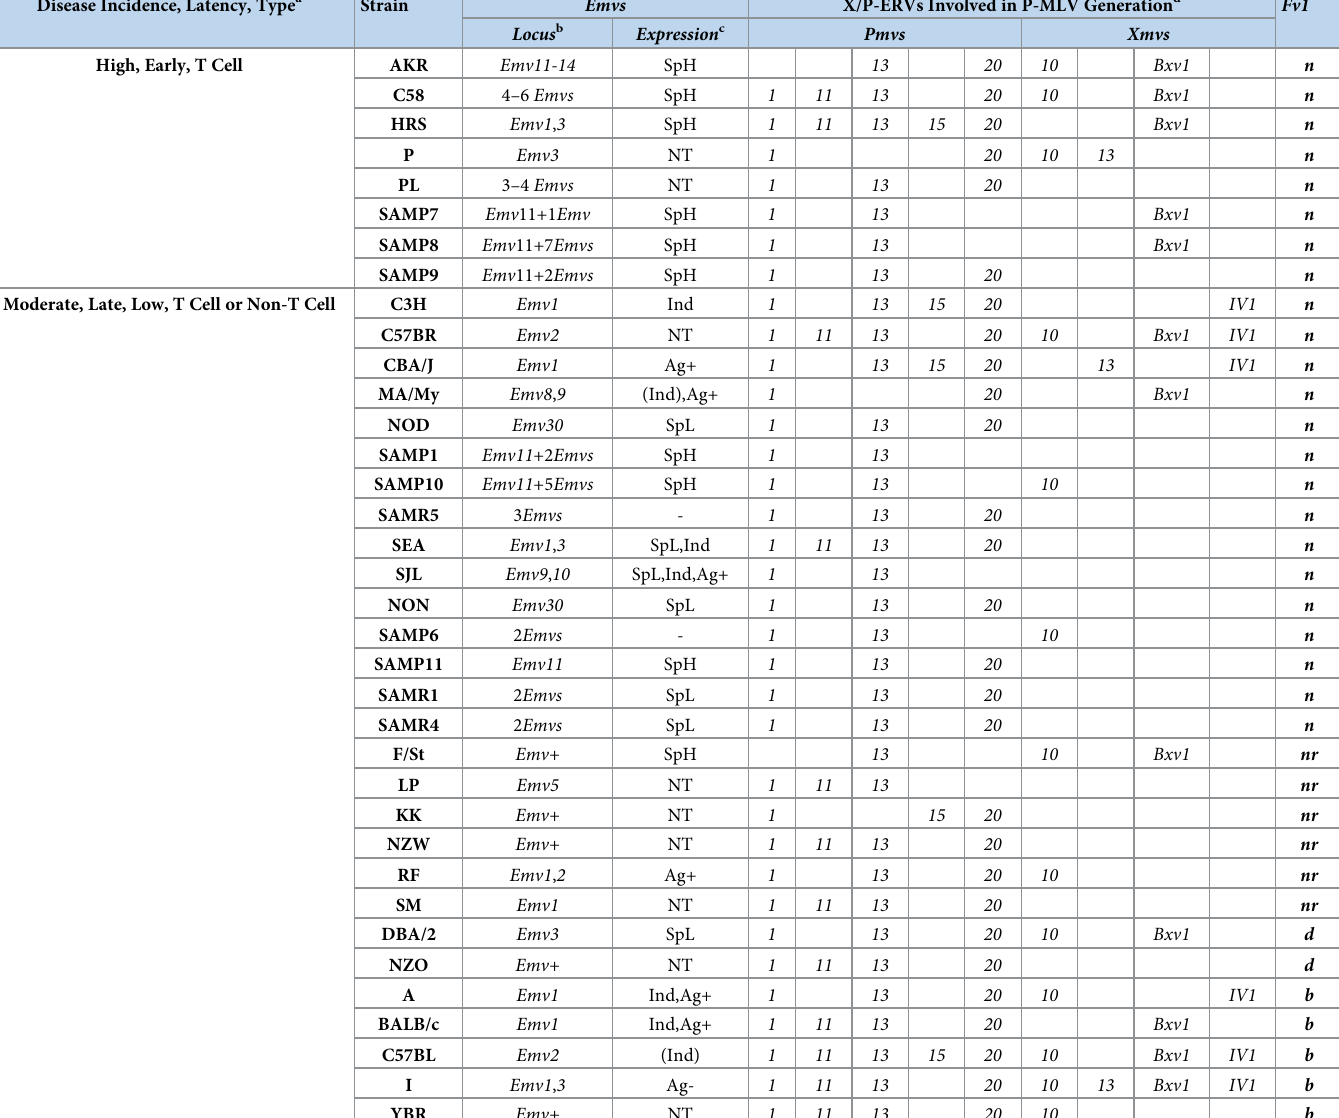
Table 1. Characterization of inbred strains for naturally occurring hematopoietic neoplasms. Disease Incidence, Latency, Type